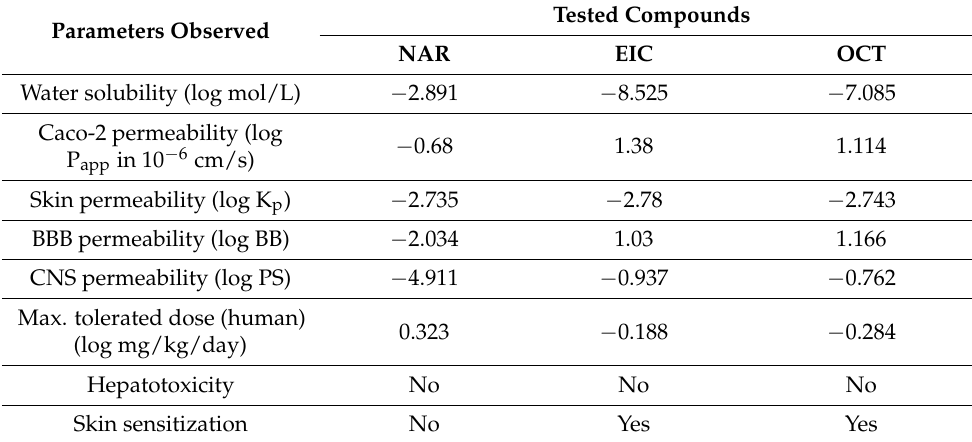
Table 6. The selected ADME parameters for the tested